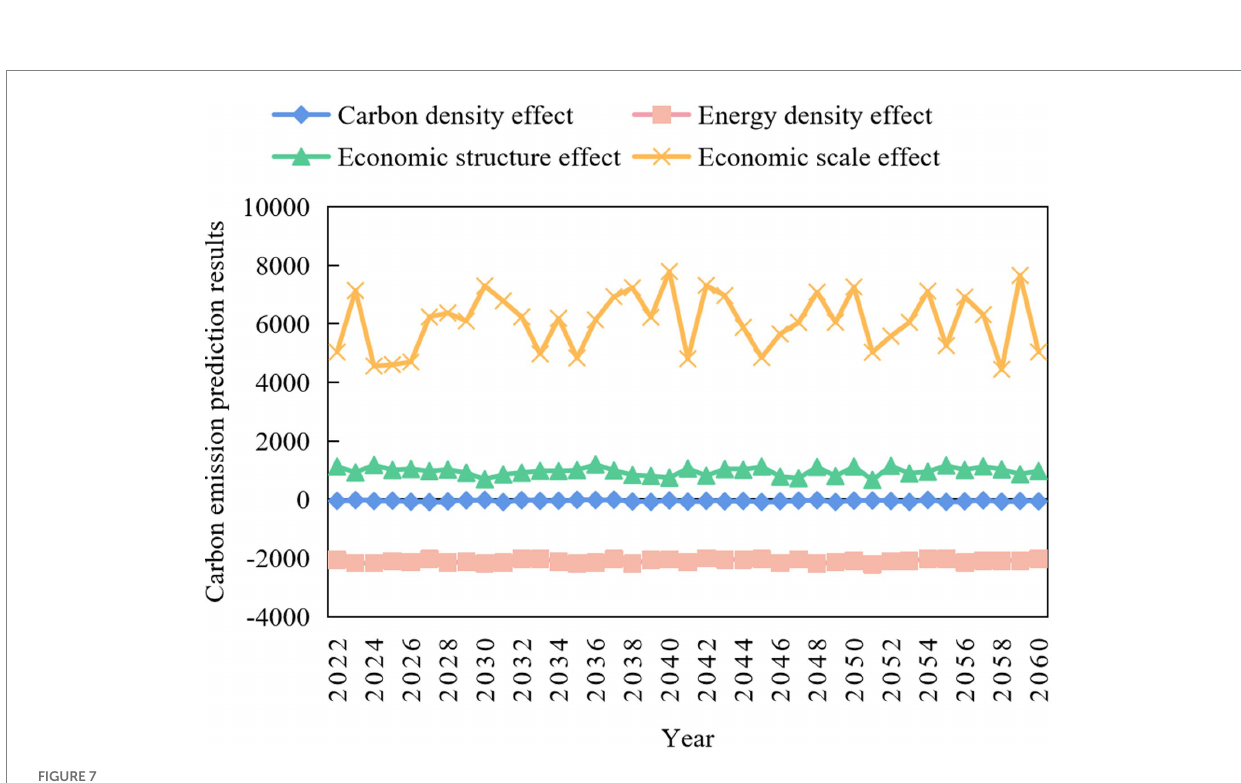
FIGURE 7 Carbon dioxide emission prediction results.